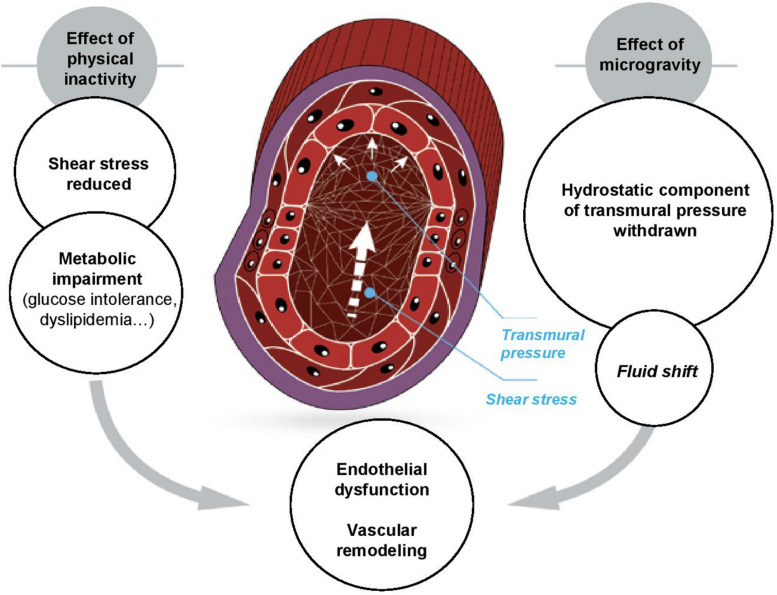
Vessels and mechanical forces in microgravity.